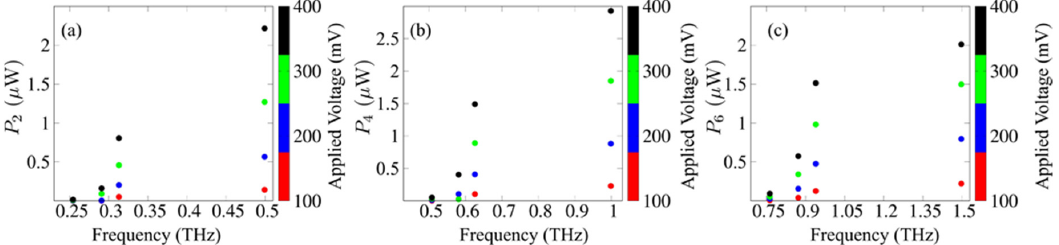
Figure 2. ( a ) Second, ( b ) fourth and ( c ) sixth harmonics output powers for SSL multipliers under the influence of a biased oscillating field for different input SLED devices over frequency ranges 250–1500 GHz for a perfectly symmetric current– voltage curve. The input frequencies and powers given respectively by 127.1, 145.3, 156.5, 249.6 GHz and 14, 4.2, 1.7, 0.92 mW.